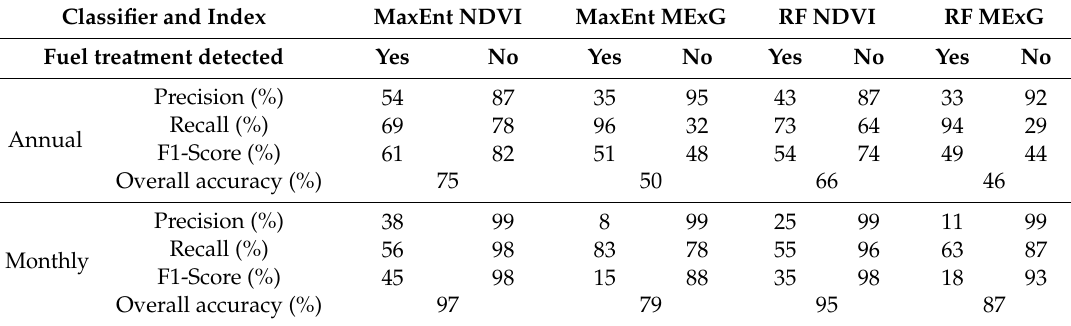
Table 3. Global accuracy results for Method 1, at annual and monthly steps.